Question: Draft a figure caption describing what is shown.
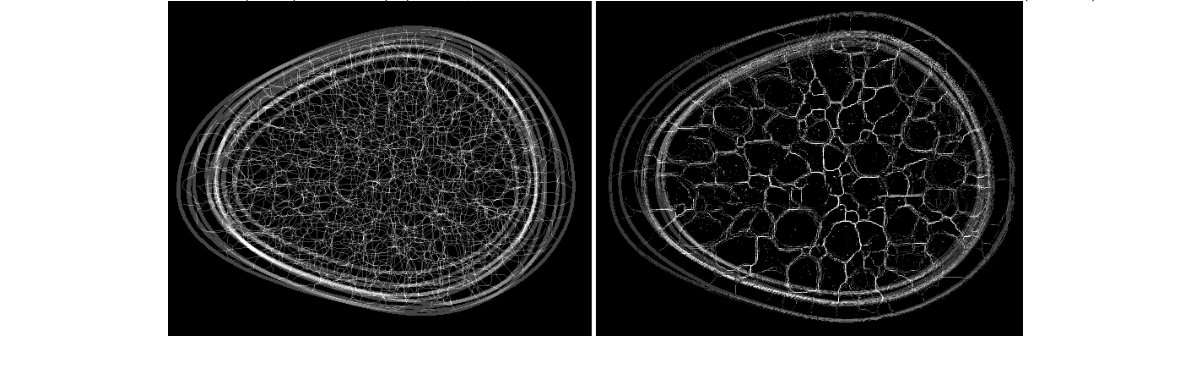
Answer: Some submissions demonstrated ligament sticking, that is, nearly constant liga- ment structure across images. Summation of 10 thresholded images of ligaments from the training data (left) demonstrates the expected randomness in ligament structure across re- alizations. This variation was clearly absent in similarly processed images (right) from a submission demonstrating this artifact.